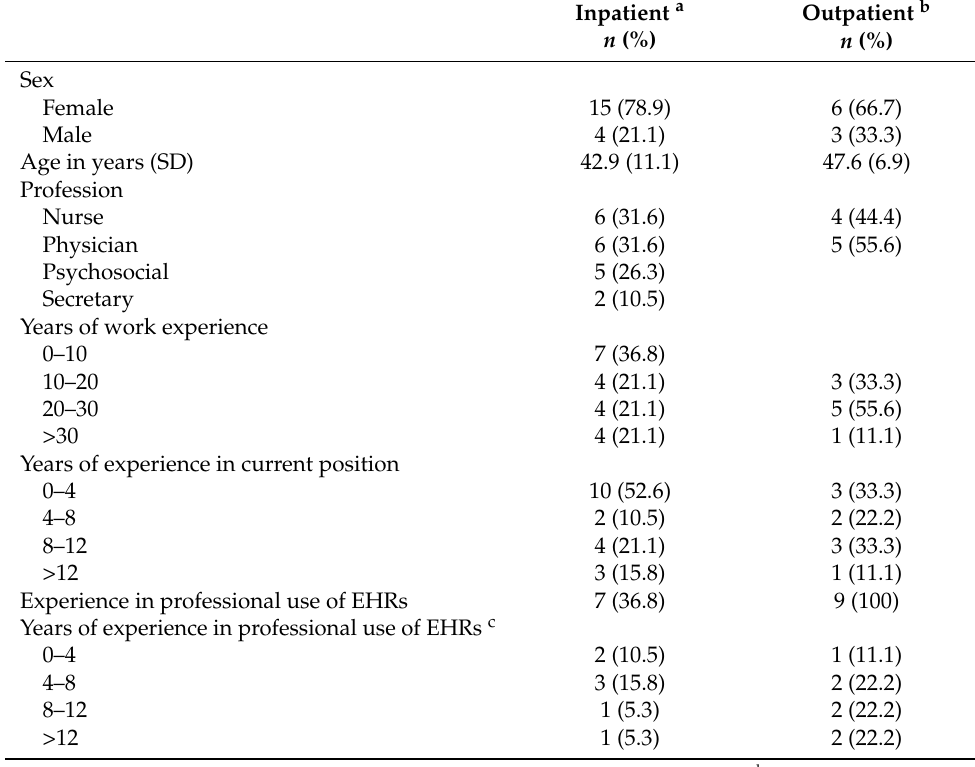
Table 1. Characteristics of inpatient ( N = 23) and outpatient ( N = 11) professionals.